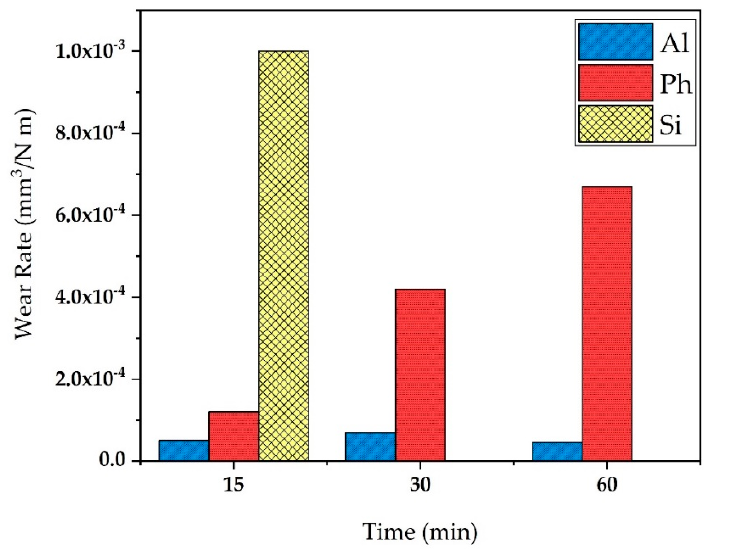
Figure 10. Wear rate of specimens at different test timings.